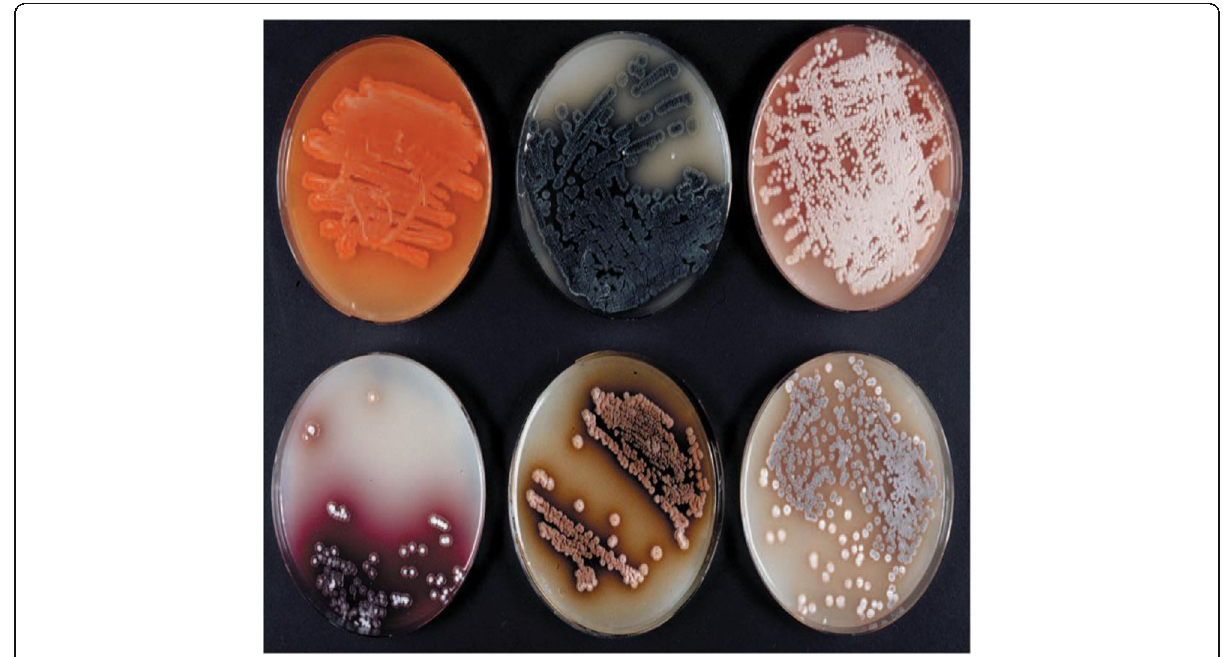
Fig. 5 Production of pigmented secondary metabolites by Streptomyces colonies